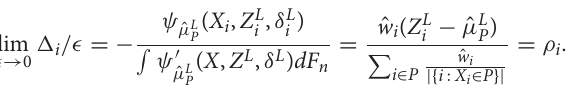
Frontiers in Genetics |